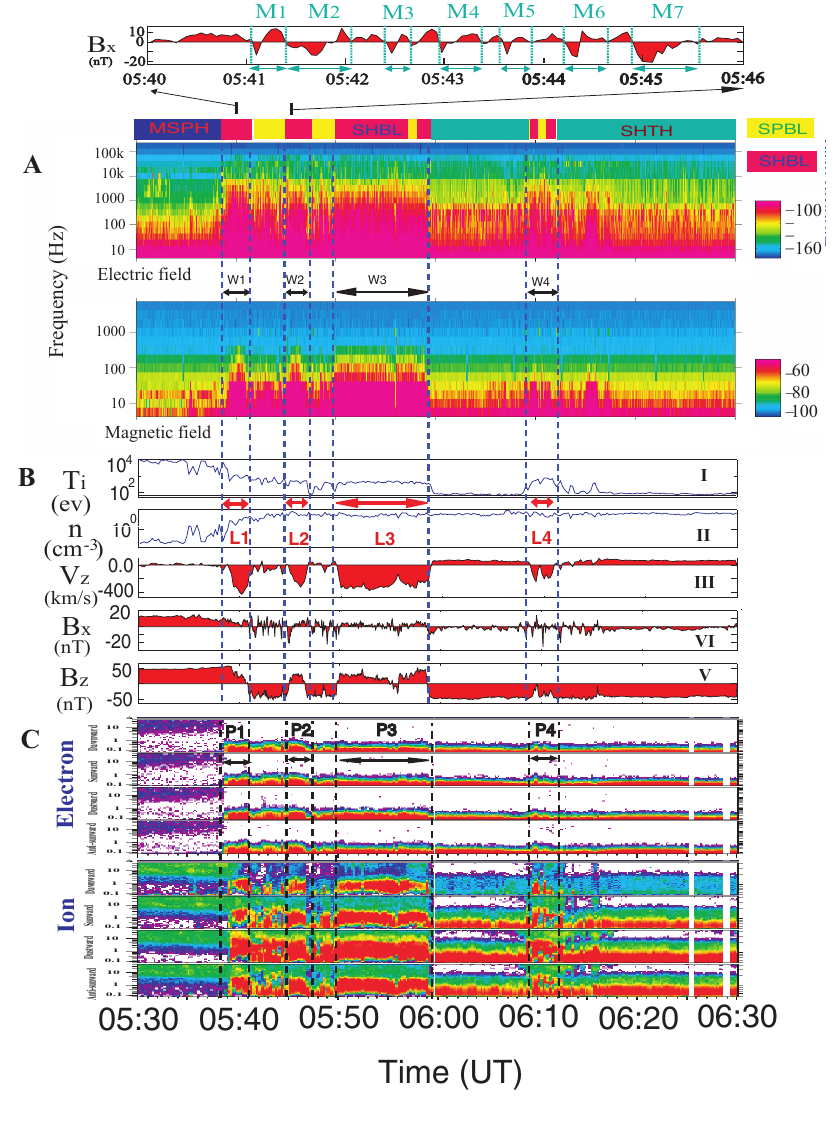
Fig. 1. GEOTAIL data from 05:30UT to 06:30UT on 10 January 1997, as the spacecraft traversed through the dayside magnetopause boundary. The GSM (geocentric solar magne- tospheric) coordinate system is used with x toward the Sun, and the x − z plane contains the Earth’s dipole axis. Frequency-time spectrograms of the plasma wave electric and magnetic field data are shown in Part A. The bar above the electric field plots identifies the region encountered. The plot above that is an expanded time-scale plot of B x magnetic field data. Part B con- tains plots of the plasma temperature, density, and z direction flow speed in panels “I”, “II”, and “III”. The mag- netic components B x and B z are shown in panels “IV” and “V”. Part C con- tains the energy-time diagrams of elec- trons and ions with dawnward, sun- ward, duskward and anti-sunward di- rections,